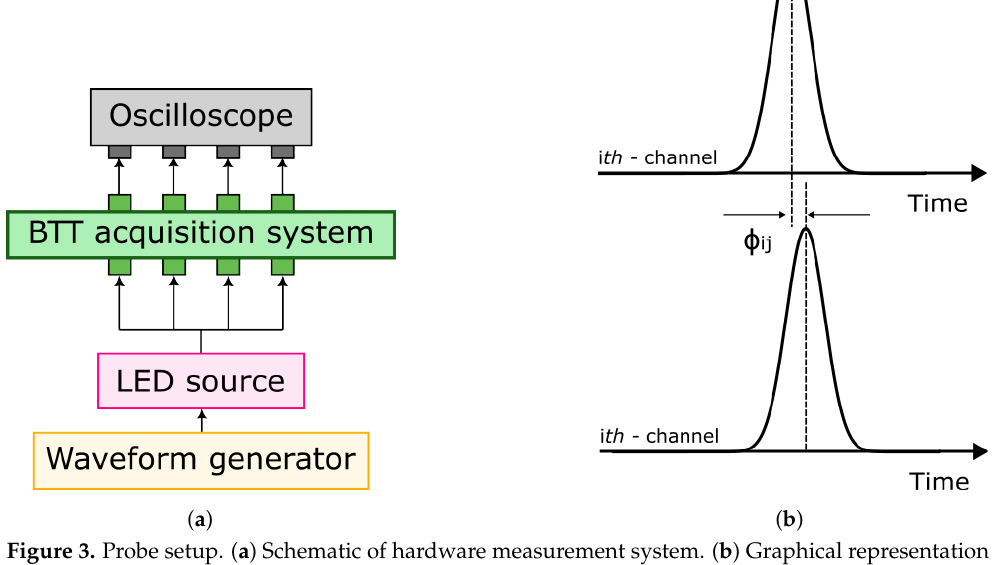
Figure 3. Probe setup. ( a ) Schematic of hardware measurement system. ( b ) Graphical representation of time-shift